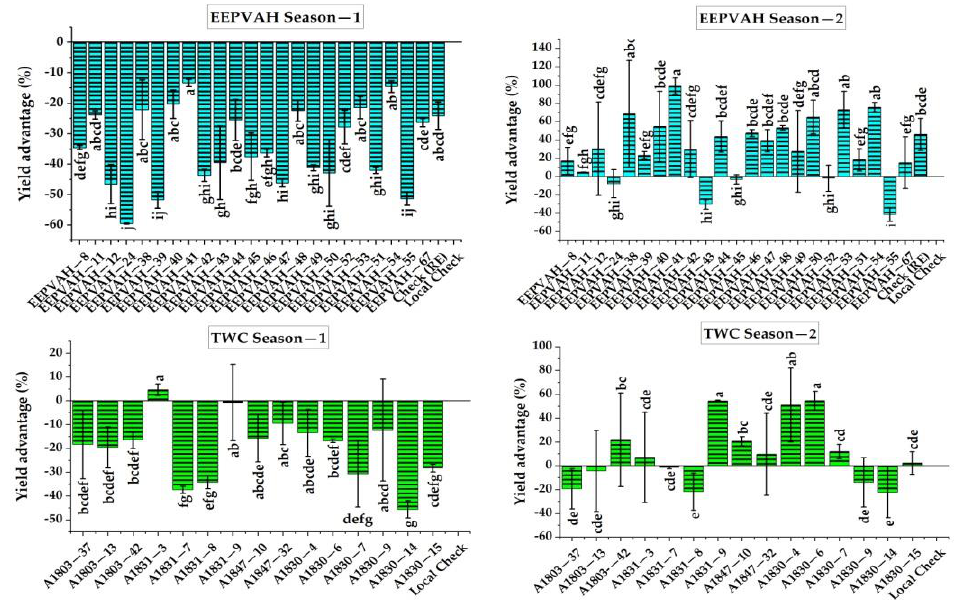
Figure 6. Yield advantage of TWC and EEPVAH genotypes over the local check recorded from two contrasting seasons. The downward bar indicates a negative yield advantage over the grain yield of the local check (DMH849). Similar statistical letters among the genotypes within the season indicates non-significant effect.